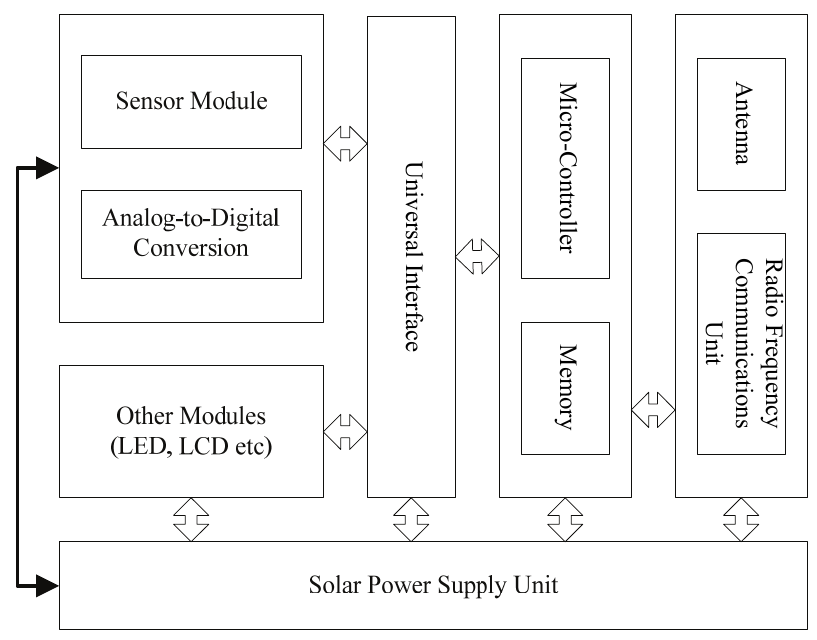
Figure 1. WSN Nodes for environmental